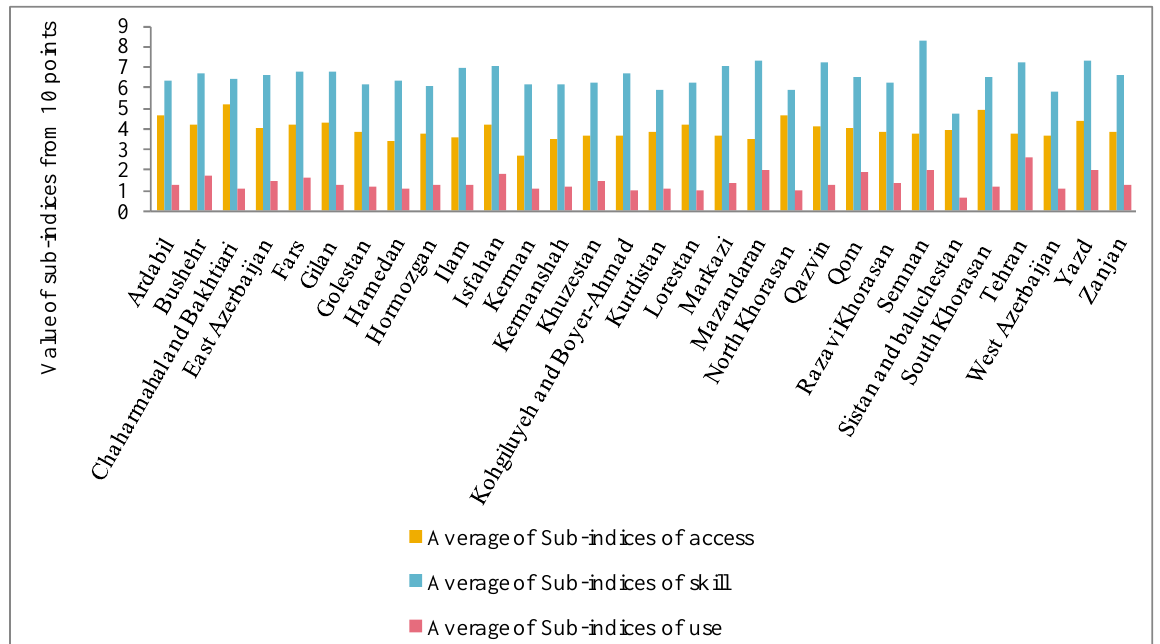
Figure 3. The average value of sub-indices of ICT in provinces of Iran during the period of 2010-2015 from 10